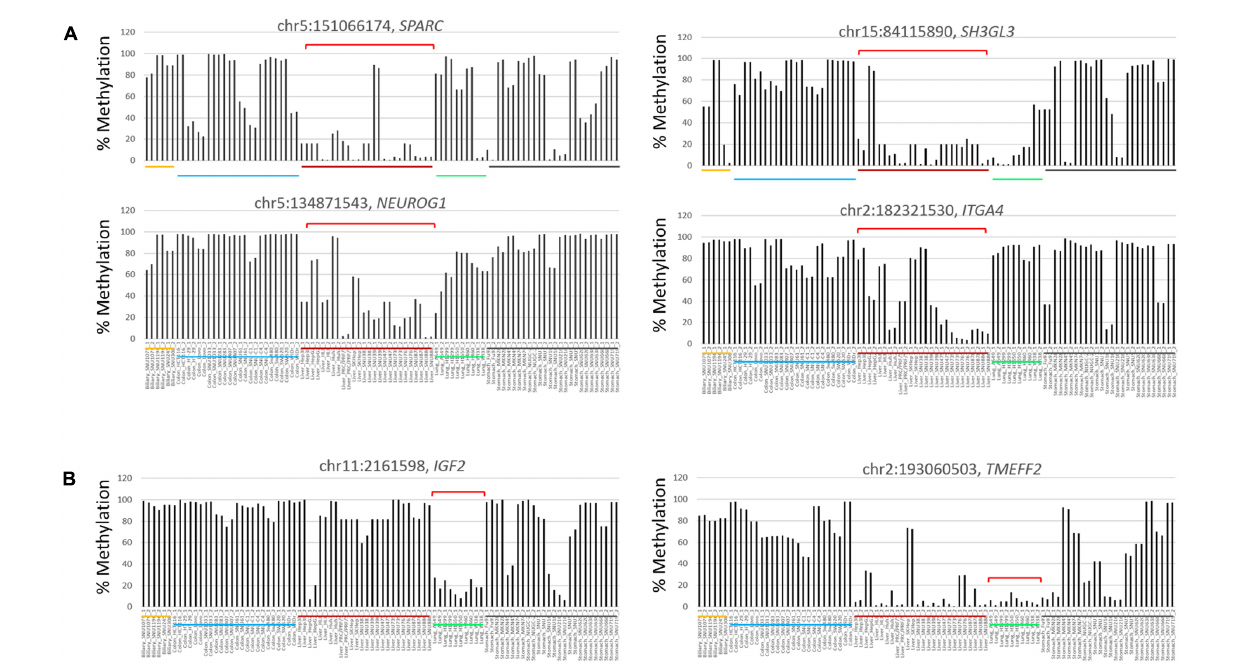
FIGURE 4 | Differentially methylated CpG sites in liver and lung cancer cell lines. Target CpGs at the SPARC, SH3GL3, NEUROG1 , and ITGA4 gene promoters are frequently undermethylated in liver cancer cell lines (A) and so are those at the IGF2 and TMEFF2 gene promoters in lung cancer cell lines (B) . Brackets (red) denote those of cell lines showing group-specific methylation patterns for indicated CpGs. Chromosomal locations of target CpG sites are represented as the chromosome (chr) number and coordinate of the position of cytosine. Each cancer cell line group is underlined below the bars (yellow, biliary tract; blue, colon; red, liver; lung, green; black, stomach